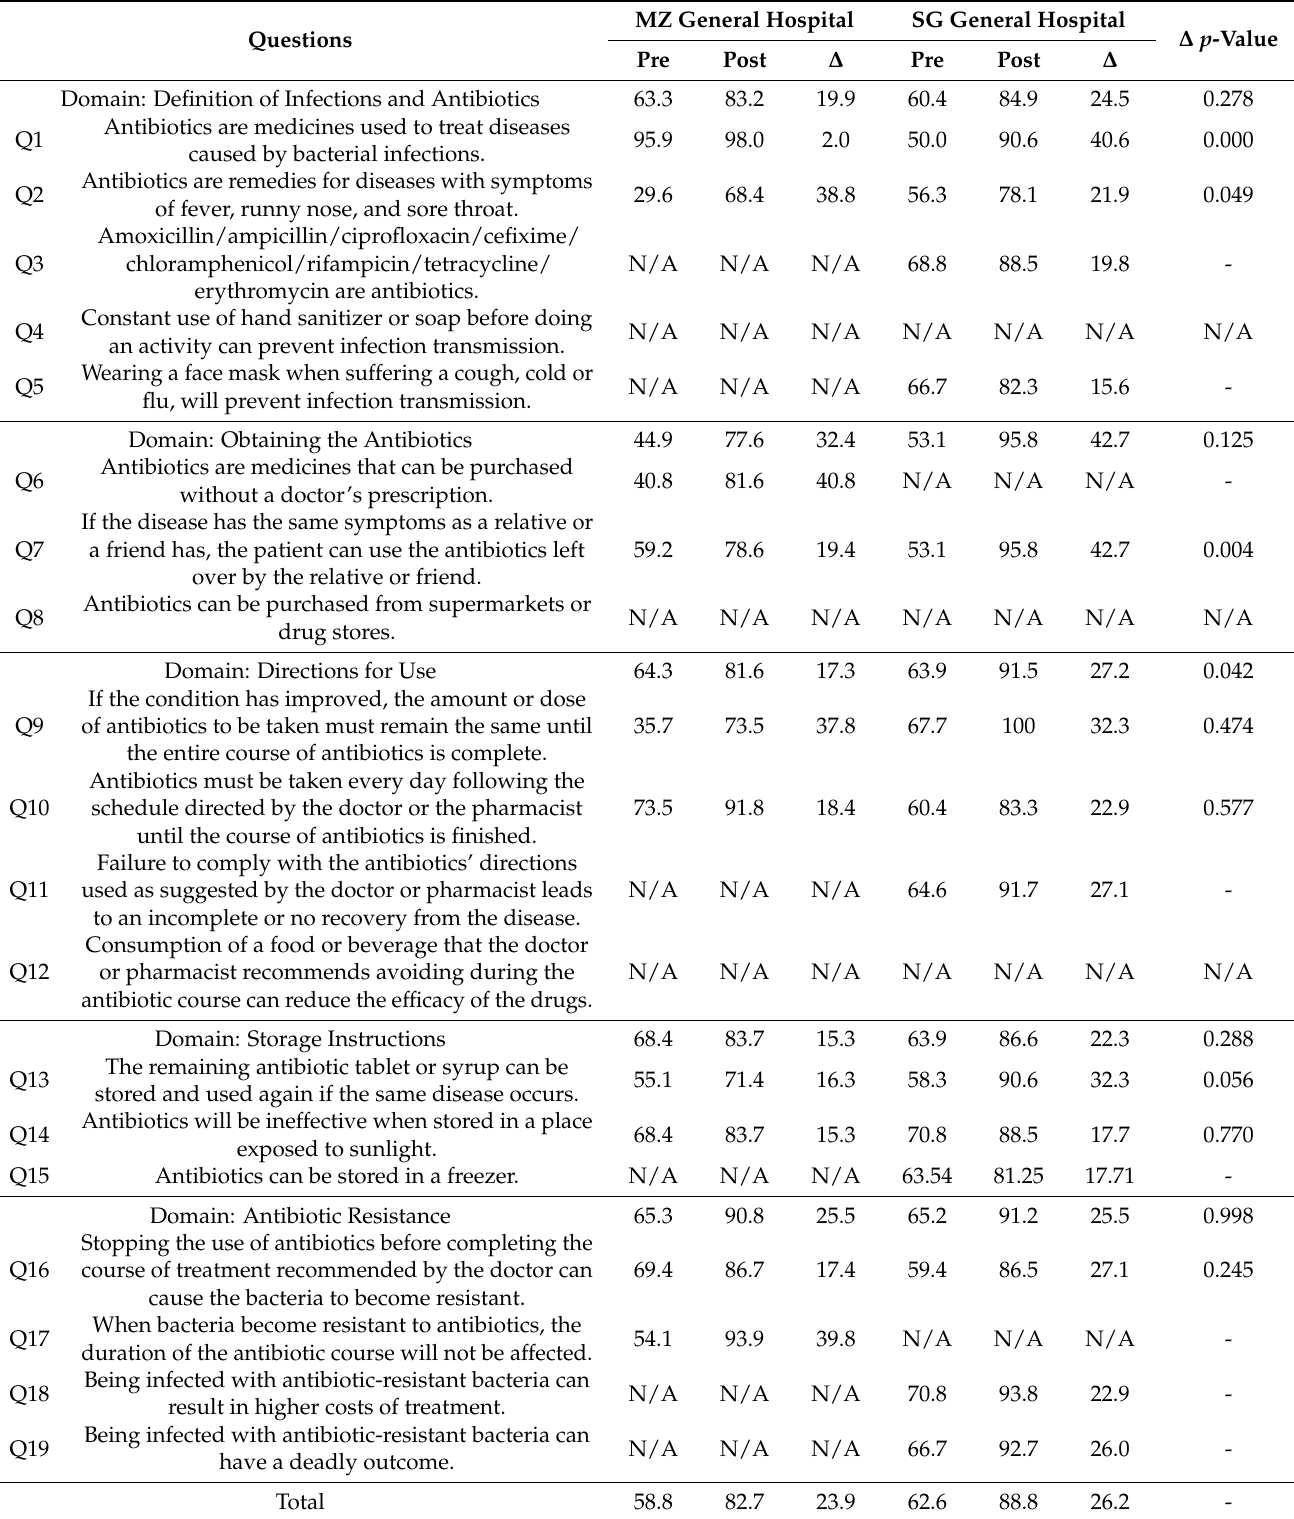
Table 2. Knowledge score test difference between